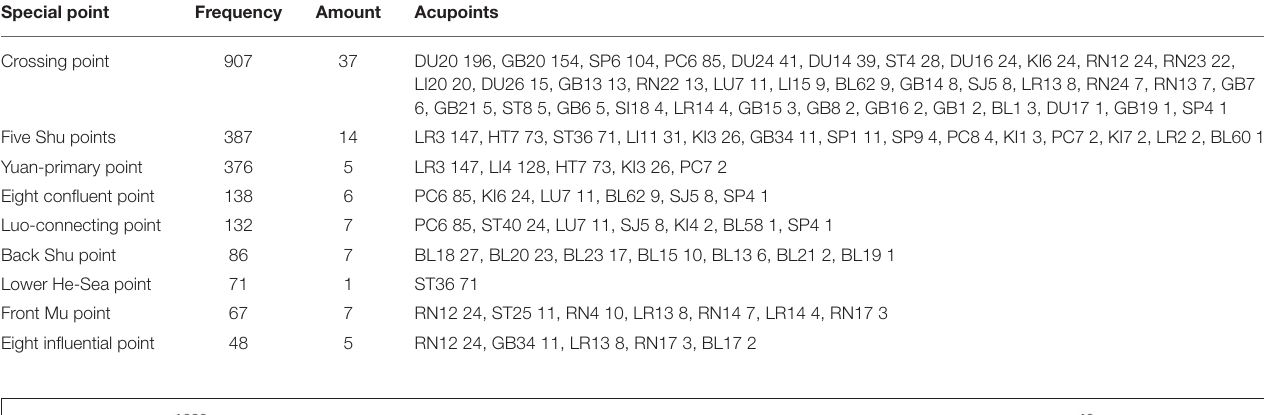
TABLE 3 | Frequency of special point application for TD treatment.